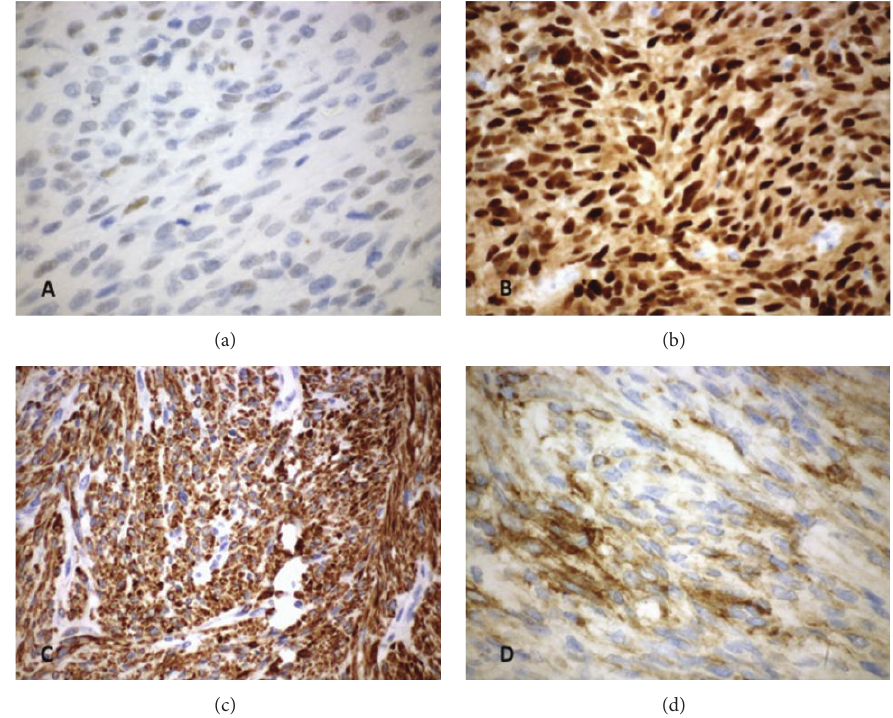
Figure 3: Immunohistochemistry: (a) estrogen receptor, (b) progesterone receptor, (c) desmin, and (d) CD10.